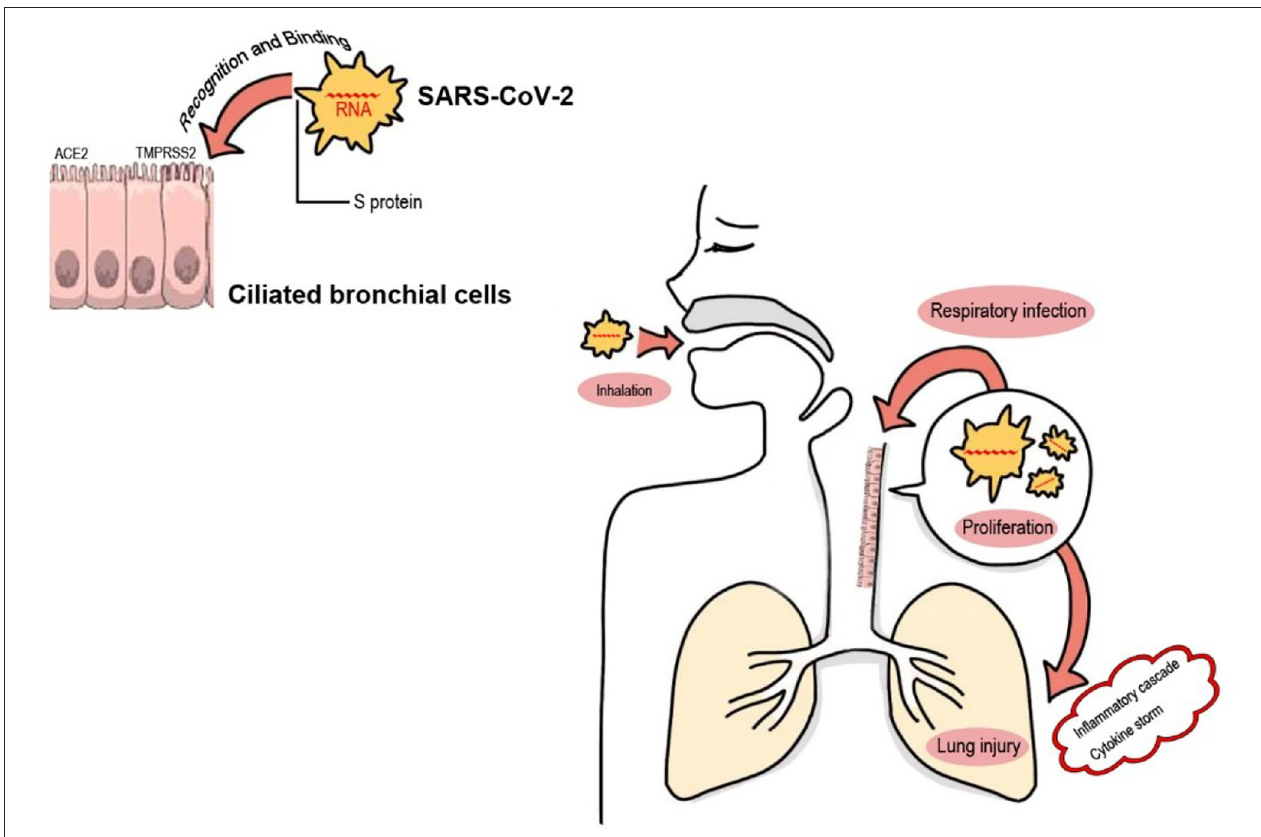
FIGURE 1 | SARS-CoV-2 infection via the airway. During inhalation, SARS-CoV-2 in the air reaches and colonizes in the bronchioles or alveoli. Spike-like protein S on the surface of the SARS-CoV-2 virus serves as a ligand, which recognizes and binds to its specific receptors (the ACE2 and the TMPRSS2 receptors) on human host cell (ciliated bronchial cell) membranes with a high affinity. This recognition and interaction between host cell membranes and viral surface molecules permit SARS-CoV-2 virus entrance into target cells resulting in intracellular proliferation of viral copies. This pathogenic process of respiratory infection leads to the activation of both extracellular and intracellular cytokines, and the subsequent “inflammatory cascade” and “cytokine storm syndromes” of COVID-19, which finally result in pulmonary or other tissue injury ( 20), or even a rare but lethal post-COVID-19 complication termed “multisystem inflammatory syndrome in children (MIS-C)”